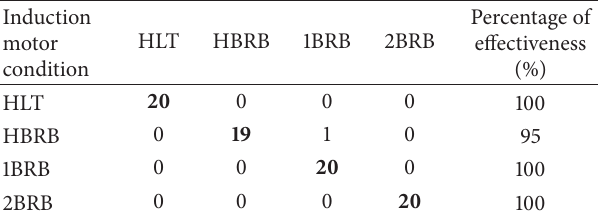
Table 3: FPGA resources. Table 4: Classification results for startup transient tests (confusion